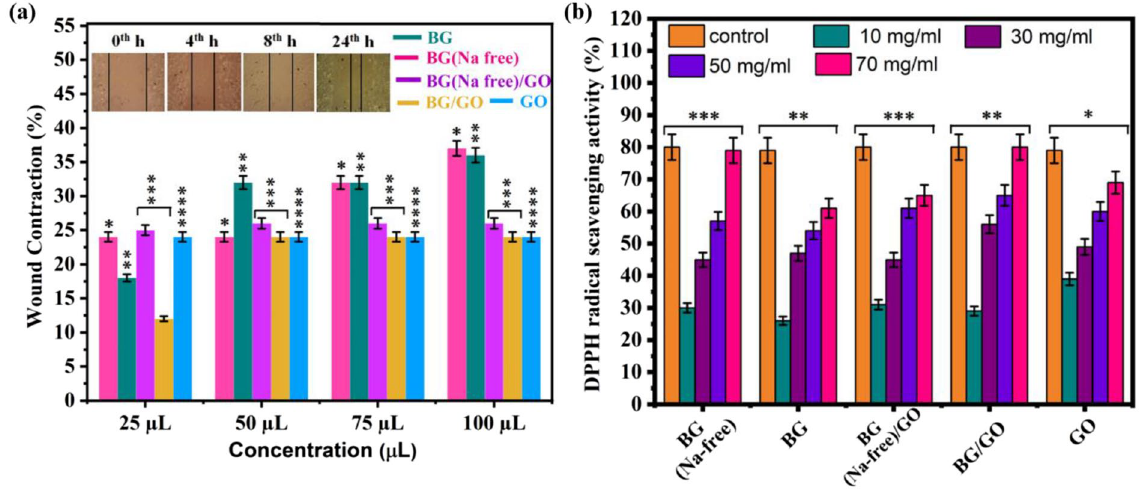
Figure 10. ( a ) Scratch assay of L929 fibroblast cells treated with BG, BG (Na-free), GO, and BG/GO, BG (Na-free)/GO nanocomposites. The asterisks indicate significant difference (*p < 0.05, **p < 0.017, ***p < 0.022, ****p < 0.055), ( b ) antioxidant activity of BG (Na-free), BG, GO, and BG/GO, BG (Na-free)/GO nanocomposites was measured using the DPPH radical scavenging assay. The asterisks indicate significant difference (*p < 0.0003, **p < 0.023, ***p <